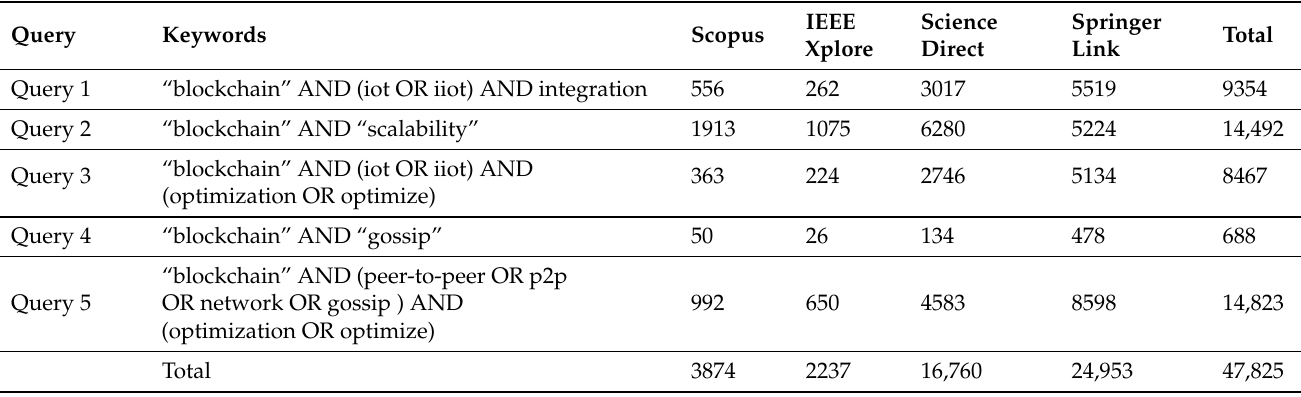
Table 1. Search Query used and the Total Number of Results Returned from Selected Databases.